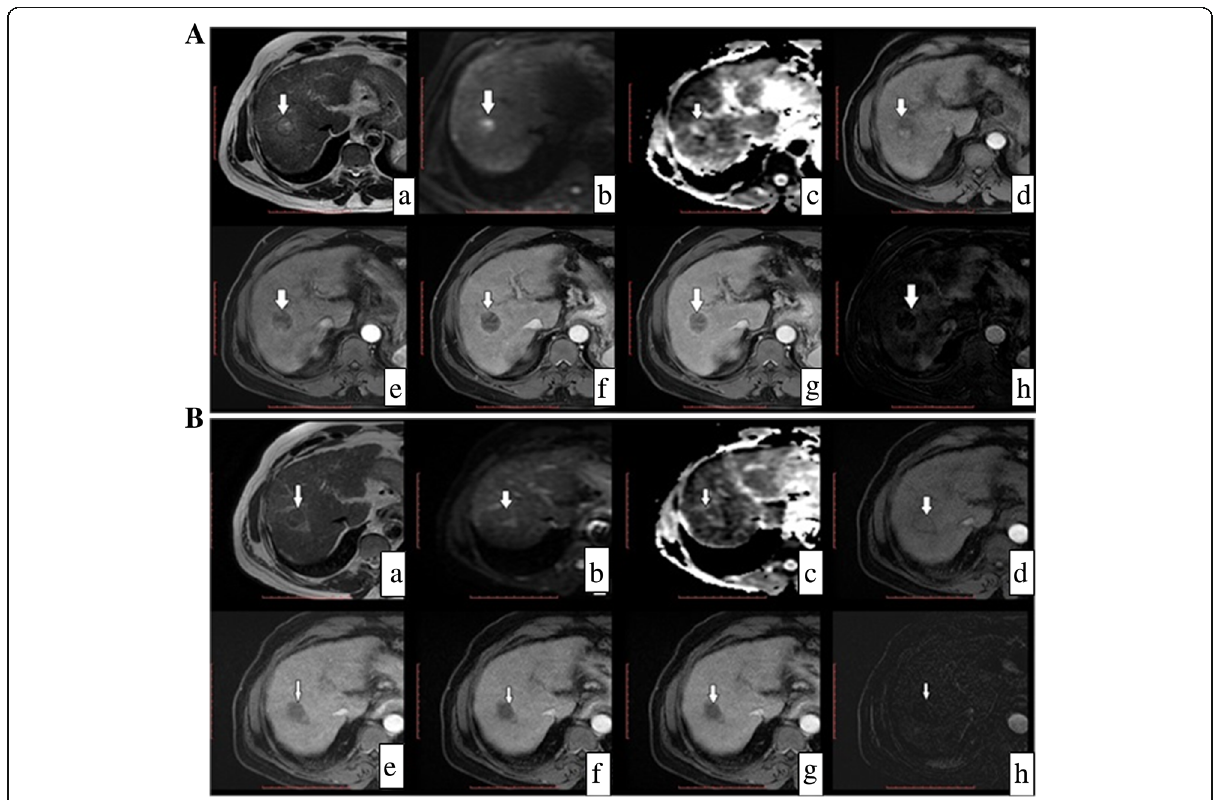
Fig. 1 A 55-year-old male patient with hepatitis-related liver cirrhosis and single segment VIII HCC lesion. He had a TACE session and came for follow up 1 and 3 months later. (A) Follow up dynamic MRI 1 month post TACE. a T2WI, b DWI image, c ADC image, d T1WI, e late arterial phase, f portal phase, g delayed phase, and h late arterial subtracted image. The treatment zone exhibits high signal in T1WIs and mildly increased signal in T2WIs with peripheral marginal enhancement. Subtraction removed the central high signal thus excluding residual disease. (B) Follow up dynamic MRI 3 months post TACE. a T2WI, b DWI image, c ADC image, d T1WI, e late arterial phase, f Portal phase, g delayed phase, and h late arterial subtracted image. Note that the lesion became of low to intermediate signal in T2WIs and iso to high signal intensity in T1WIs. The marginal enhancement became inconspicuous. High signal that was detected on the DWI is decreased in the follow up. No enhancement detected at the subtraction images confirming the complete